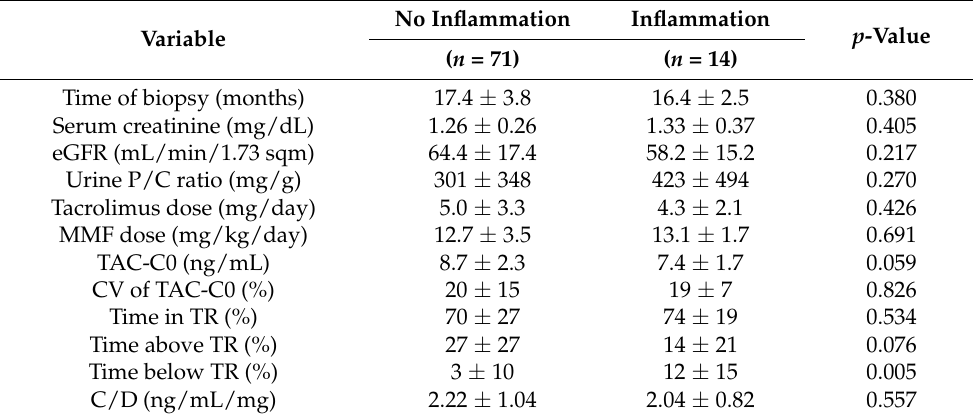
Table 5. Clinical and therapeutic drug monitoring data in patients with (i-score ≥ 1) and without (i-score = 0) interstitial inflammation in the second surveillance biopsy.